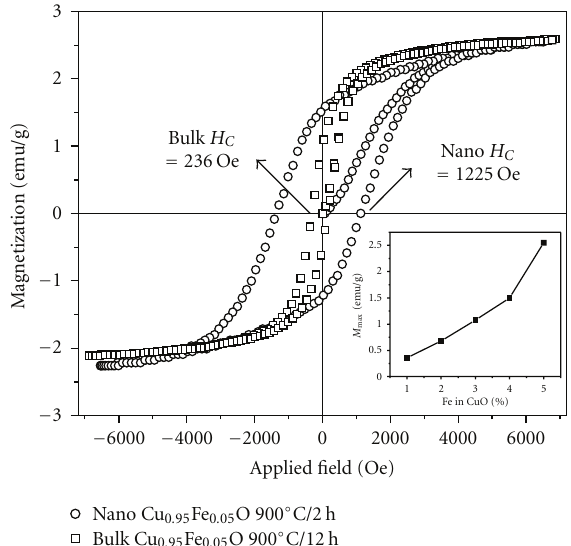
Figure 14: Room temperature hysteresis loops of bulk and nano- crystalline (50 hour refluxed, annealed at 900 ◦ /2h) Cu 0 . 95 Fe 0 . 05 O showing five-fold increase in coercivity. Inset shows the increase in M max value with increasing “Fe” concentration in nanocrystalline samples.